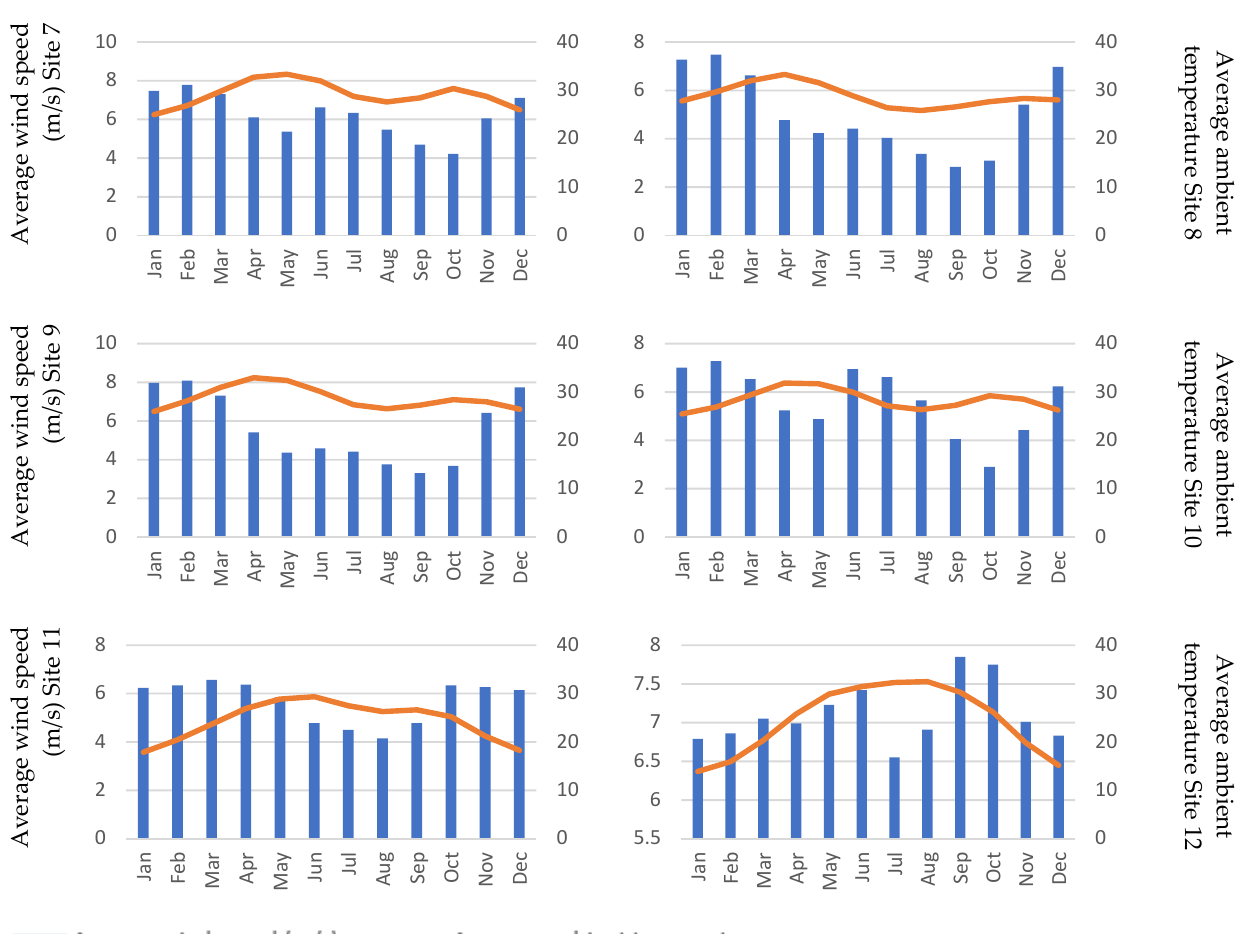
Figure 11. Average wind speed and ambient temperature for the 12 sites (the x -axis represents the month of the year, and the primary y -axis represents the speed in m/s; the secondary y -axis represents the average ambient temperature).